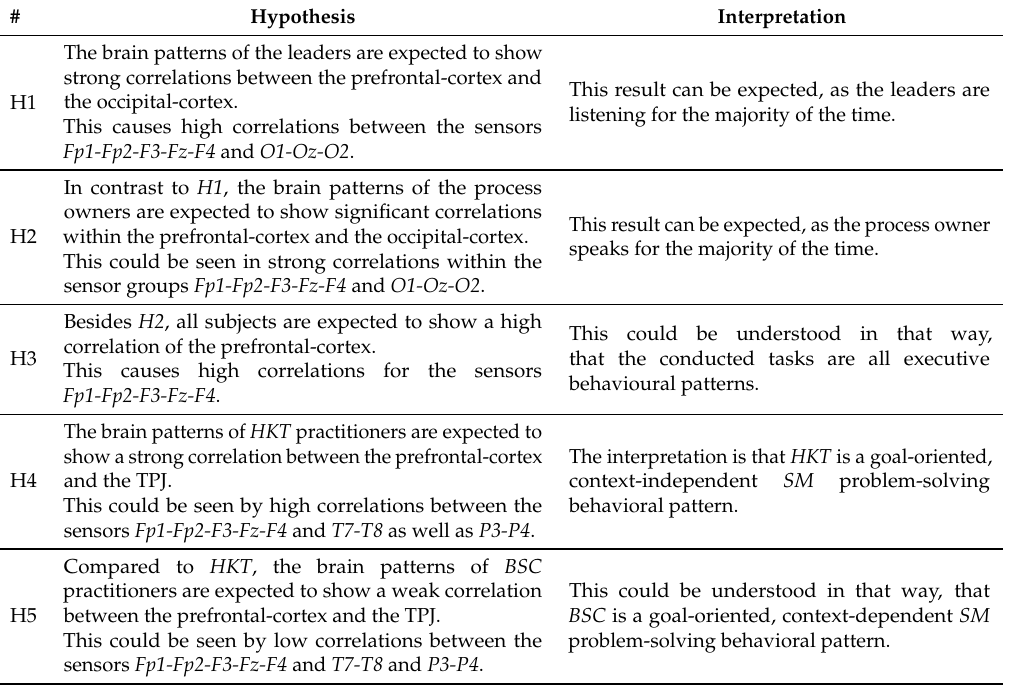
Table 1. Hypotheses regarding the correlations of the recorded electroencephalography (EEG)-data. #